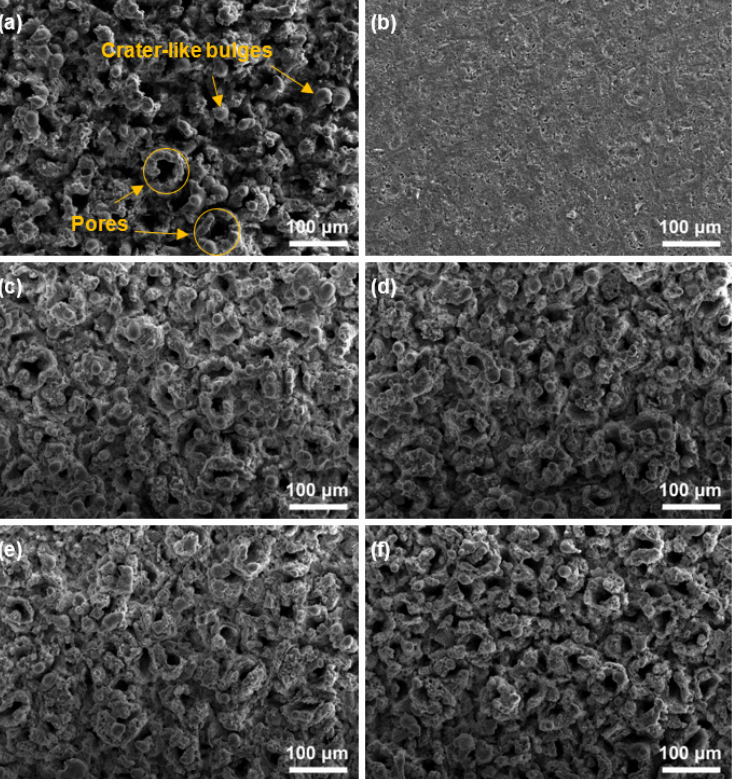
Figure 4. SEM morphologies of CPED coatings: ( a ) surface morphology of sample S0; ( b ) surface morphology of sample S0 in contact with the substrate; ( c - f ) surface morphologies of samples S5, S10, S15 and S20.